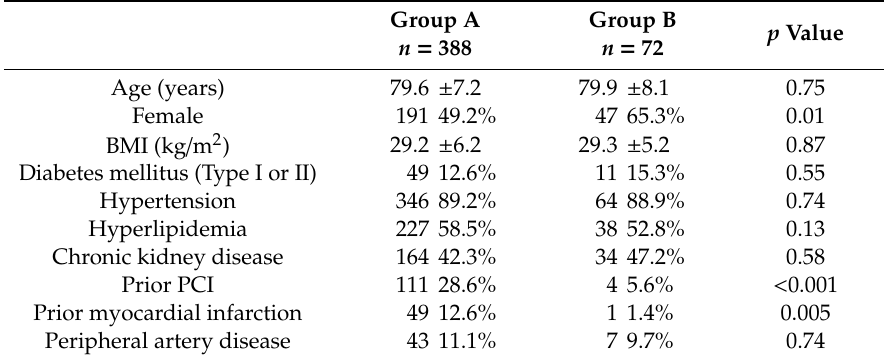
Table 1. Baseline